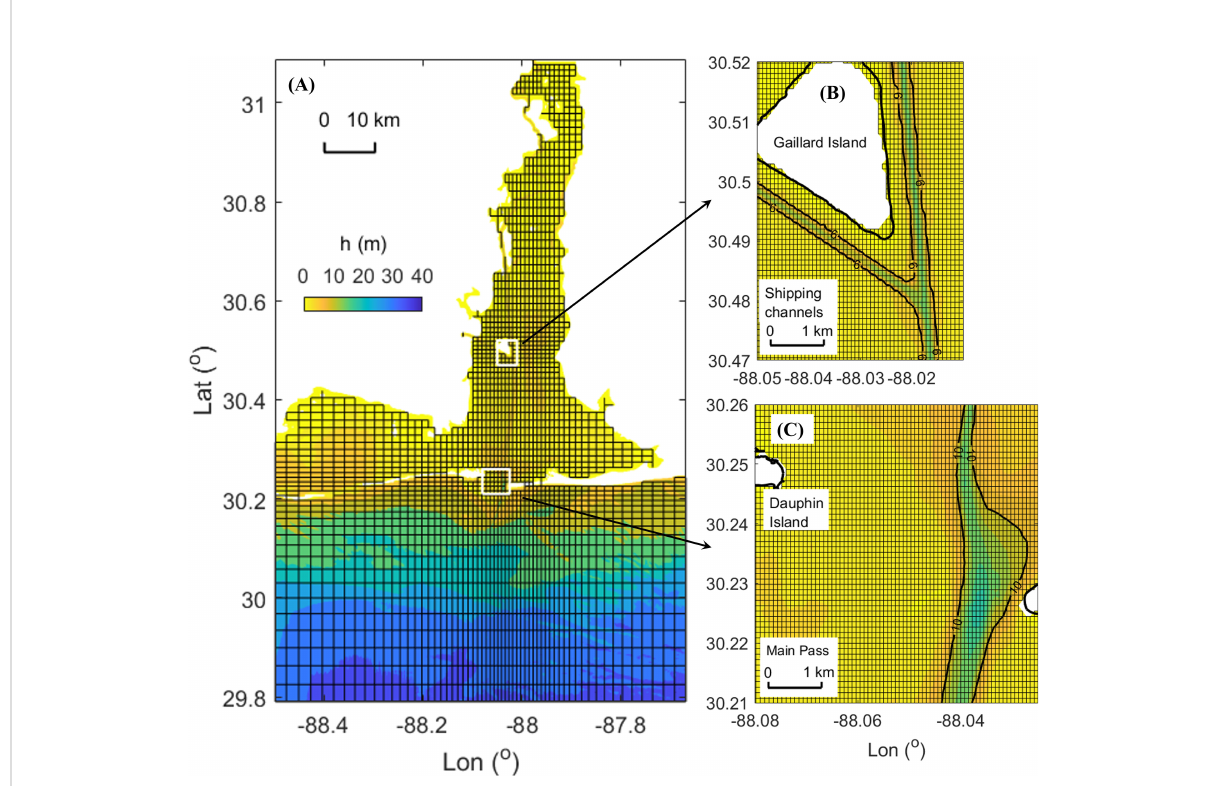
FIGURE 2 ROMS model domain and grid. (A) Sketch of grid over entire domain. Real resolution is 10-fold fi ner of the sketch. White boxes denote subregions of panels (B, C) . (B) Real grid in shipping channels. (C) Real grid around Main